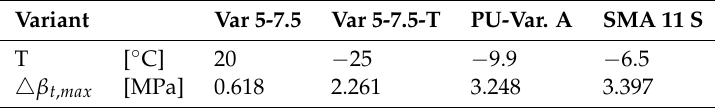
Figure 13. Results of the low temperature behavior of Var-5-7.5-T. Table 4. Results of low temperature behavior of Var 5-7.5, Var 5-7.5-T from this study and PU-Var. A and SMA 11 S from